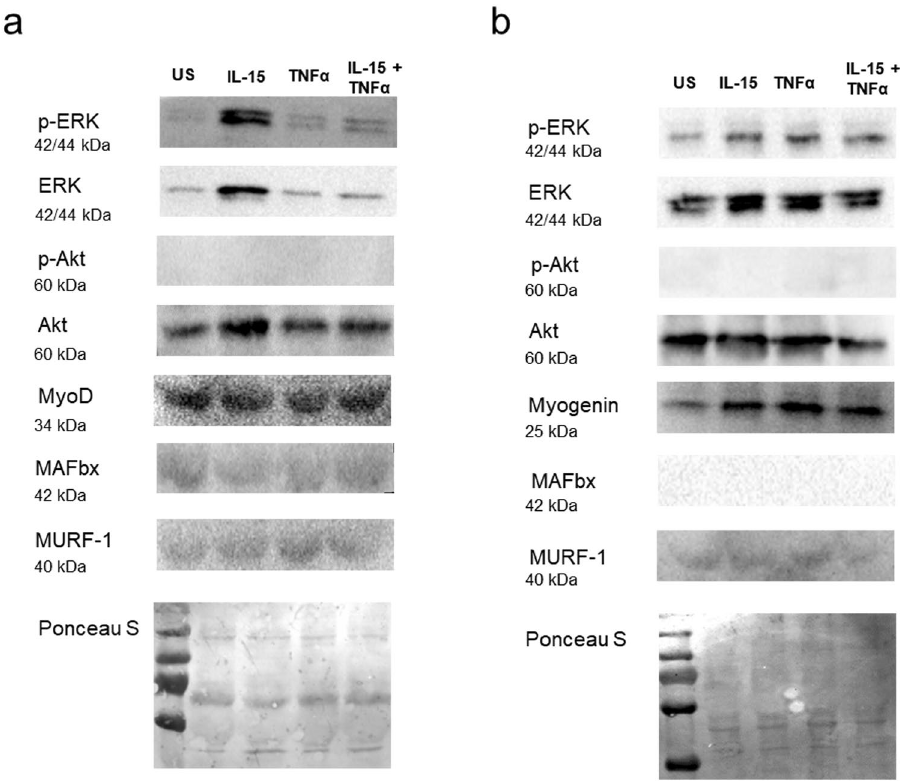
Figure 3. Recombinant IL-15 stimulation of primary human myogenic cultures induces molecular changes that suggest it has pro-myogenic actions. ( a ) Commercially available subconfluent myoblasts from a female aged 21 yr were switched to growth medium containing the indicated recombinant cytokines (IL-15, 25 ng/mL; TNF α , 1 ng/mL) for 2 d. The expression of the indicated proteins was determined by immunoblotting. Full- length blots are presented in Supplementary Figure 6. Blots are representative of duplicate independent experiments. ( b ) Commercially available subconfluent myoblasts from a female aged 21 yr were switched to differentiation medium containing the indicated recombinant cytokines (IL-15, 25 ng/mL; TNF α , 1 ng/mL) for 2 d. The expression of the indicated proteins was determined by immunoblotting. Full-length blots are presented in Supplementary Figure 6. Blots are representative of duplicate independent